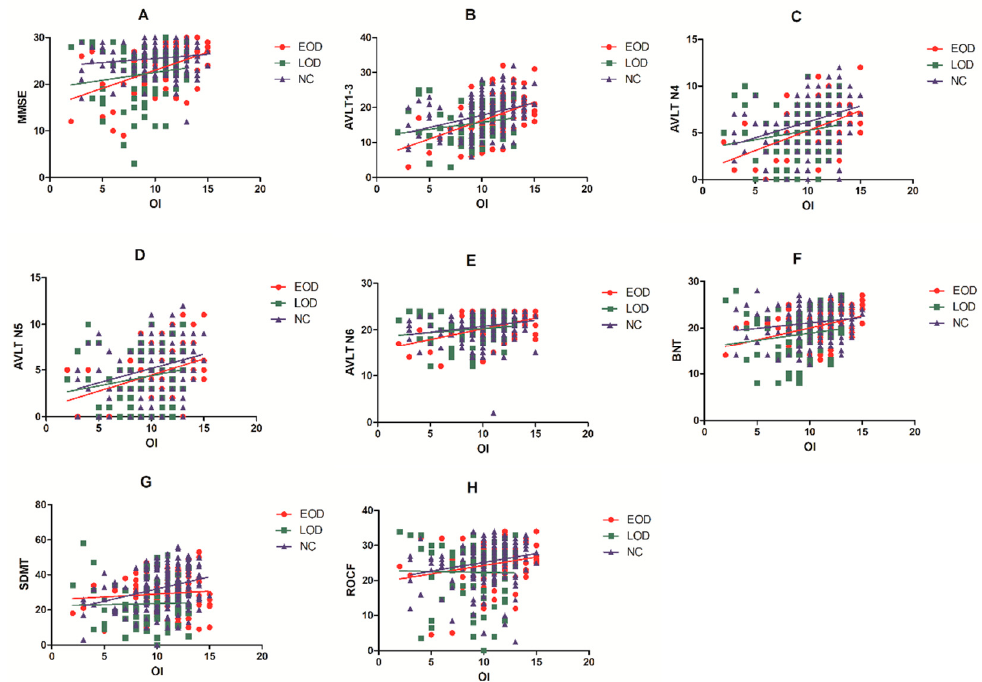
Figure 2. Correlational analyses between cognitive function and OI in EOD, LOD and NC groups.